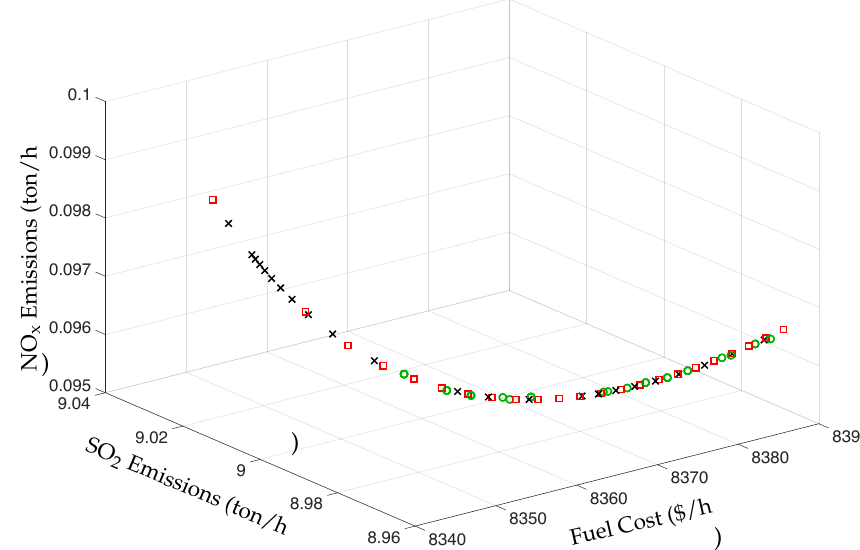
Figure 6. Pareto front for fuel cost, SO 2 emissions, and NO x emissions constructed using 25 elements. Red squares represent SQP, green circles represent NSGA-II , and black × represent NPHC.